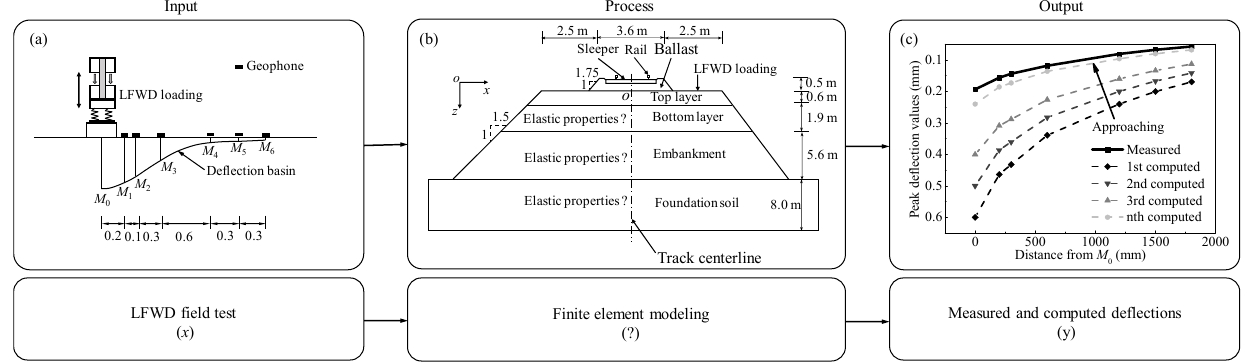
Figure 2. Inverse problem ( a ) input: LFWD field test; ( b ) process: finite element modeling; and ( c ) output: comparison of measured and computed deflections.